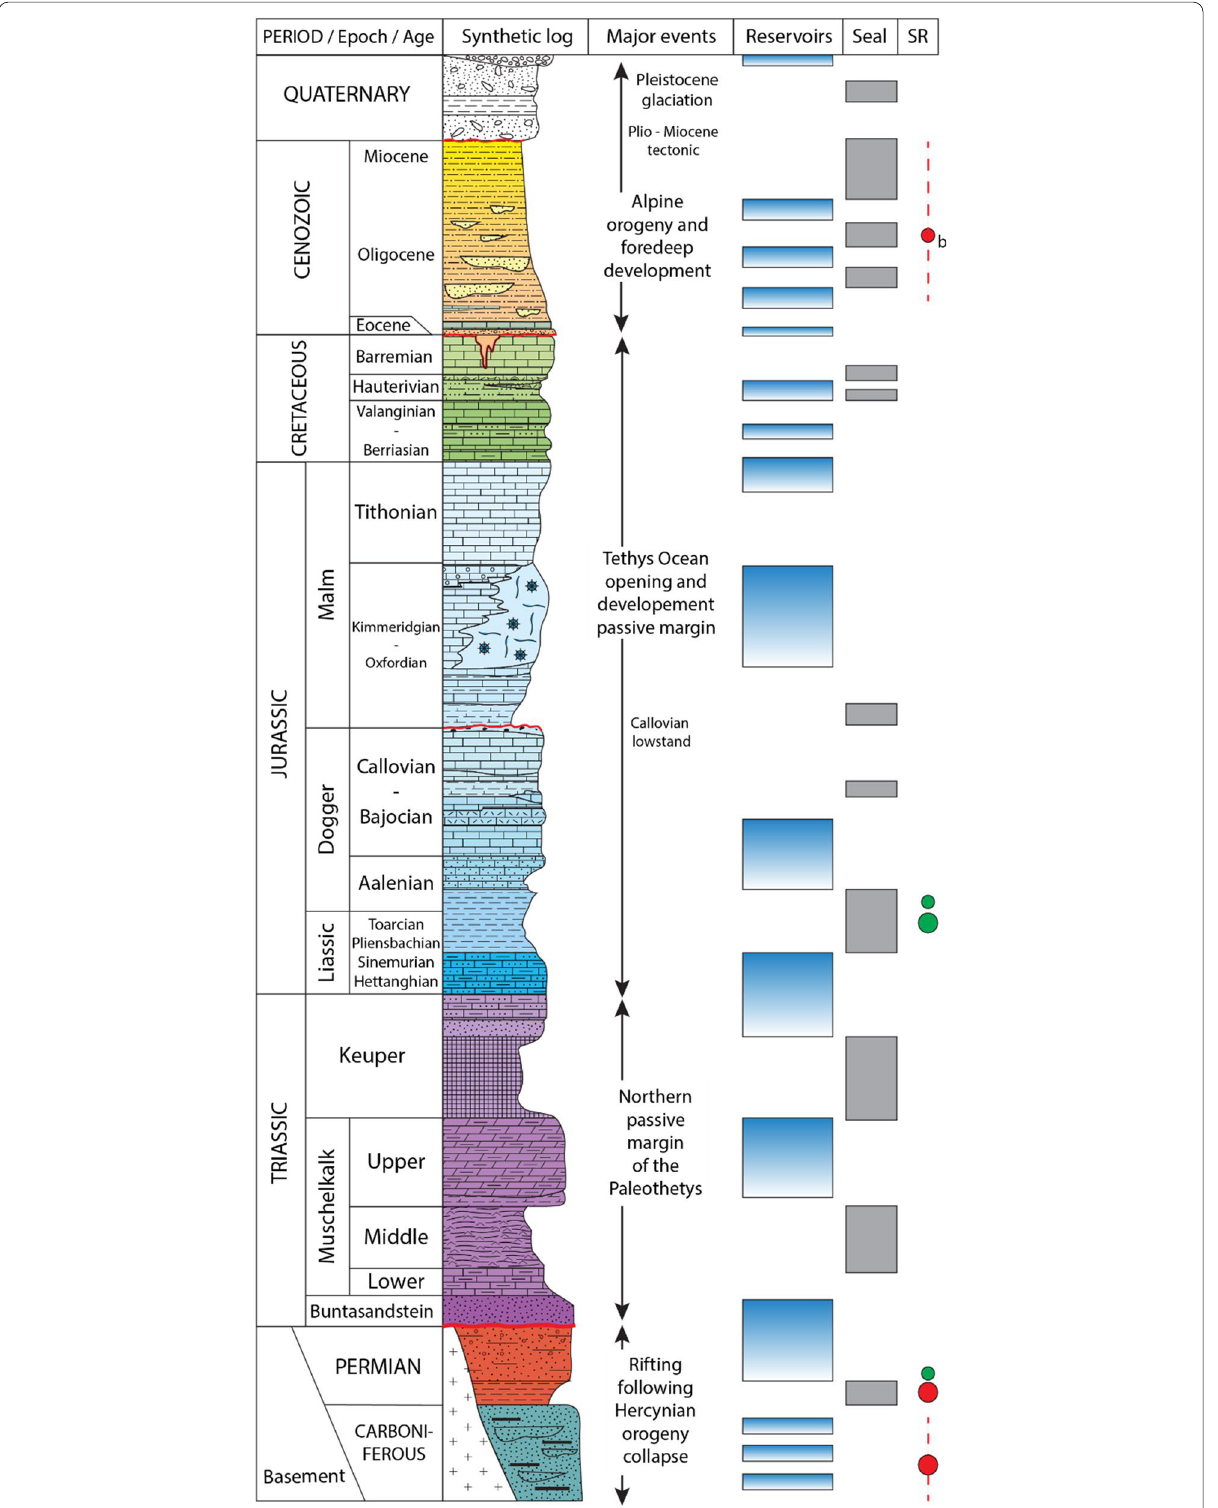
Fig. 2 Synthetic stratigraphic log of the southwestern Molasse Basin (based on well records and Leu 2012) with indication of potential reservoirs, seals and hydrocarbon source rocks (SR). Triassic and Jurassic nomenclature includes stratigraphic subdivisions commonly used in the Swiss Plateau. SR large circle: major SR; small circle: minor SR; green: oil; red: gas; b: